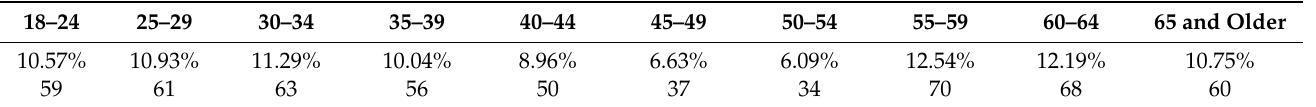
Table 2. Respondents’ age distribution